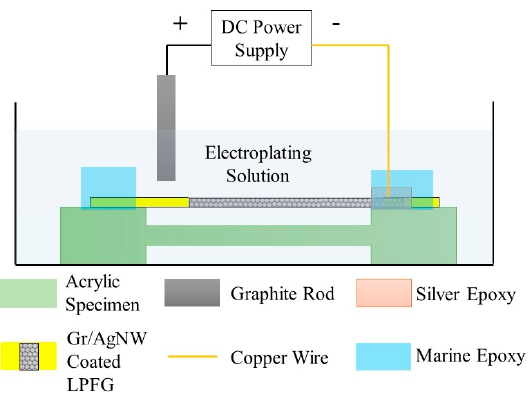
Figure 3. Schematic illustration of the Fe-C electroplating setup.